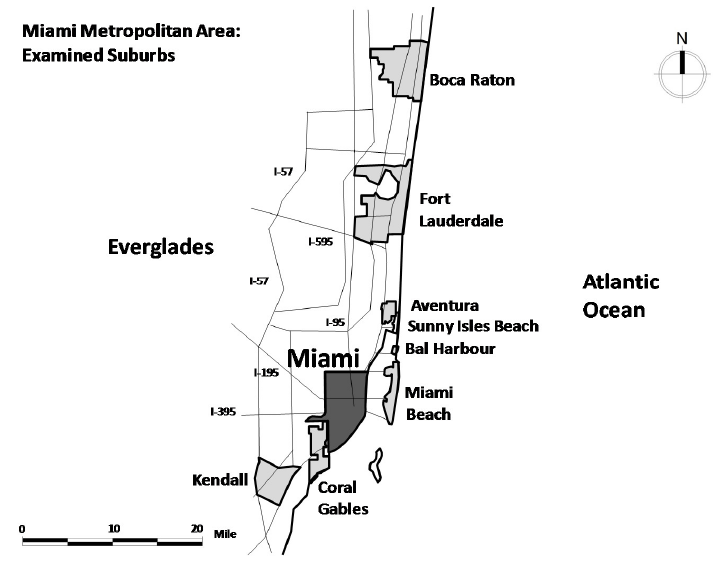
Figure 3. Locations of the examined suburbs in the Miami Metropolitan Area.